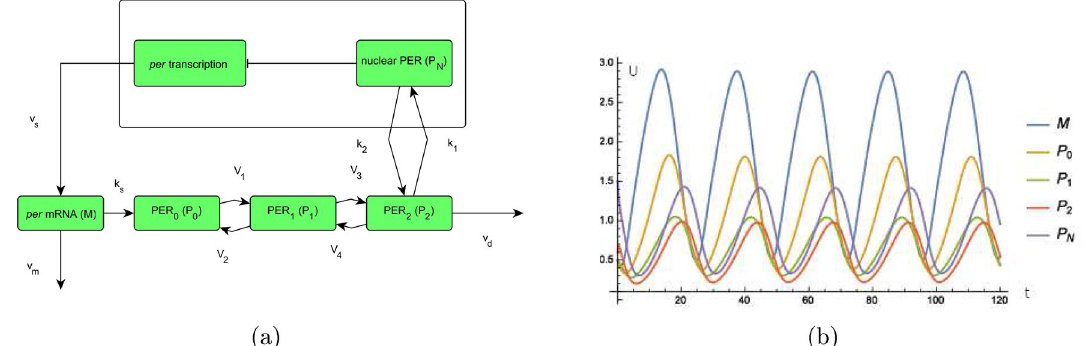
Figure 1. ( a ) Model for circadian PER oscillations, see 14 . Scheme of the model for circadian oscillations of PER and per mRNA. The system of the equations is given by (1) to (5). The per mRNA ( M ) is transcribed in the nucleus and is transported to the cytosol, where it accumulates at a maximum rate v s ; thereby it is degraded by an enzyme of maximum rate v m and Michaelis constant K m . The rate of translation of the PER protein, that is proportional to M , is characterized by a first-order rate constant k s . The parameters V i and K i , i = 1, 2, 3, 4 , denote the maximum rate and Michaelis constant of the kinase(s) and phosphatase(s) involved in the reversible phosphorylation of P 0 into P 1 and P 1 into P 2 of the PER protein, respectively. The fully phosphorylated form ( P 2 ) is degraded by an enzyme of maximum rate v d and Michaelis constant K d , and transferred into the nucleus at a rate characterized by the first-order rate constant k 1 . Transport of the nuclear, biphosphorylated form of PER ( P N ) into the cytosol is characterized by the first-order rate constant k 2 . The negative feedback exerted by nuclear PER on per transcription is described by an equation of the Hill type, in which n denotes the degree of cooperativity and K I the threshold constant for inhibition. ( b ) A plot of the model (1) to (5) with the parameters M M M v s = 0.76 µ v m = 0.65 µ v d = 0.95 µ k 1 = 1.9 1 k 2 = 1.3 1 K m = 0.5 µ M , k s = 0.38 1 K I = 1 µ M , M M M M h , h , h , h , h , h , V 2 = 1.58 µ V 3 = 5 µ V 4 = 2.5 µ K d = 0.2 µ M , n = 4 , K 1 = K 2 = K 3 = K 4 = 2 µ M , V 1 = 3.2 µ h , h , h , h with the initial values M ( 0 ) = 0.5 , P 0 ( 0 ) = 0.5 , P 1 ( 0 ) = 0.5 , P 2 ( 0 ) = 0.6 , P N ( 0 ) = 1.5 . Units and